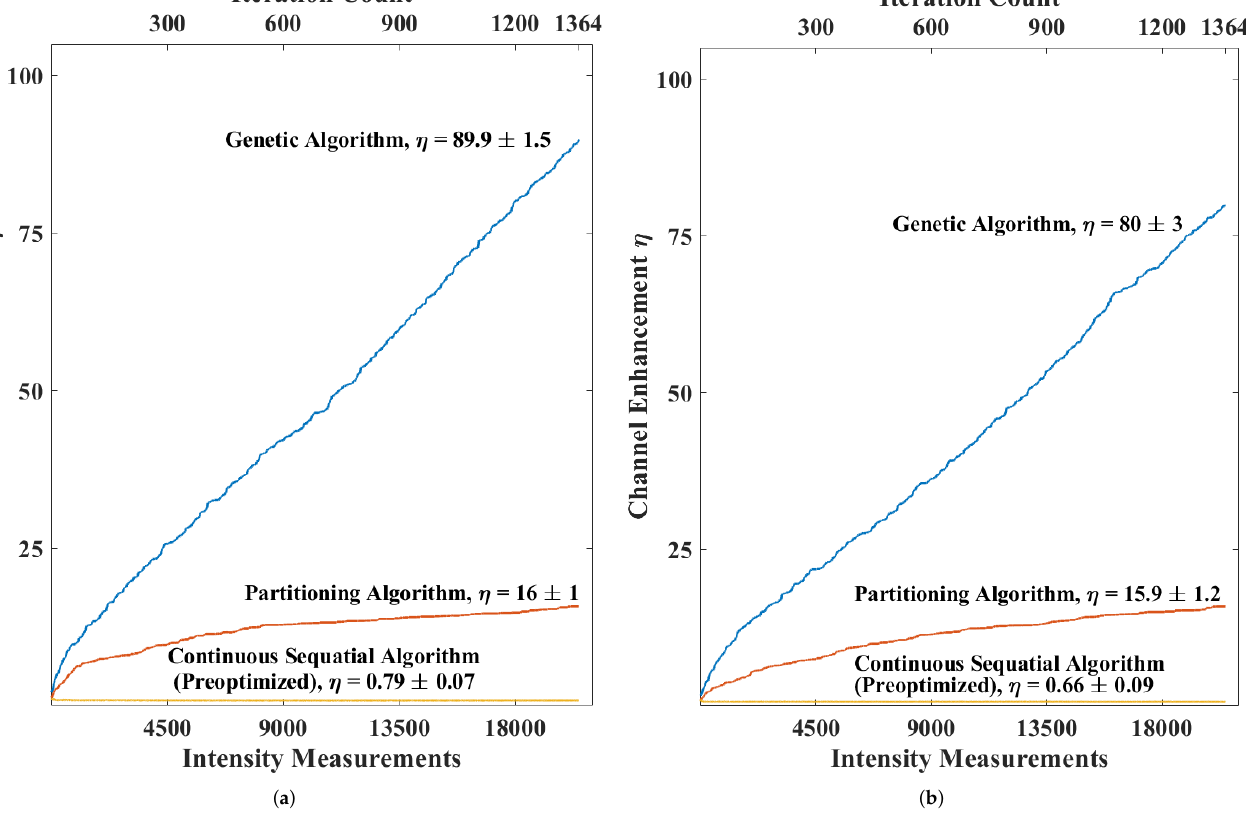
Figure 2. Enhancement achieved using different techniques for reflective inverse diffusion. In ( a ), the performance on 600 grit polished nickel is shown. In ( b ) the performance on zinc oxide white paint is